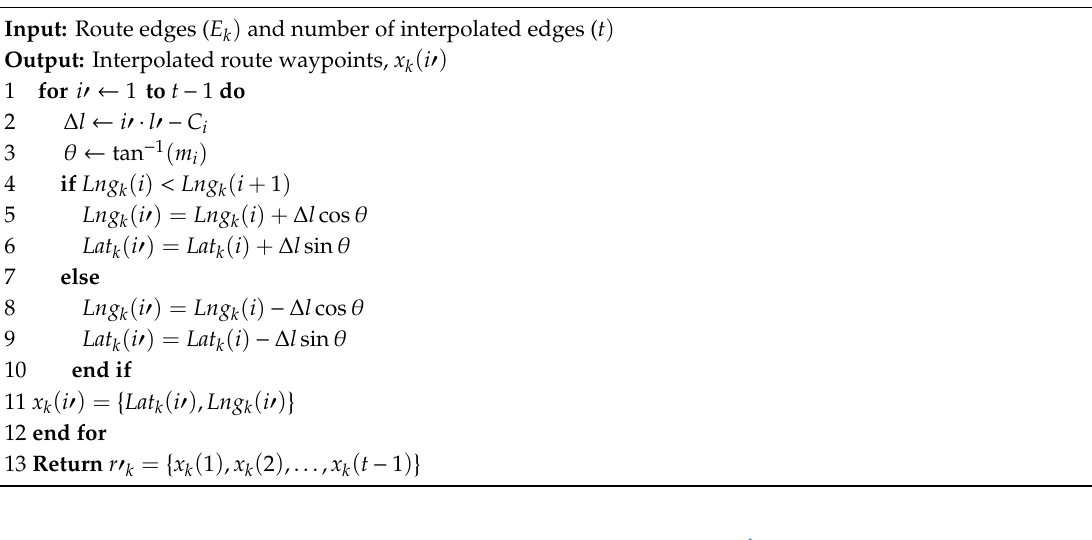
Algorithm 2: To obtain interpolated route waypoints.